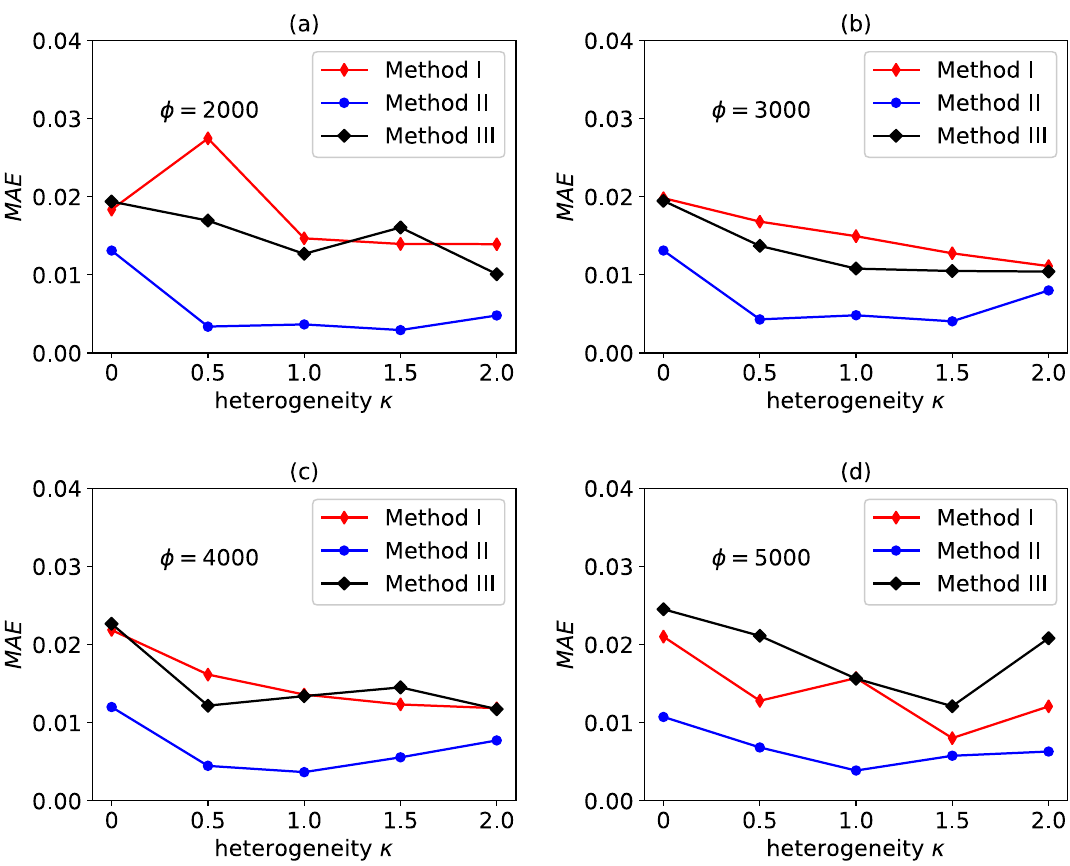
Figure 13. MAE for the validation dataset at convergence, for the NNs (19), (22) and (24), as a function of the heterogeneity κ and the number of training data points φ . Data are shown for models I, II and